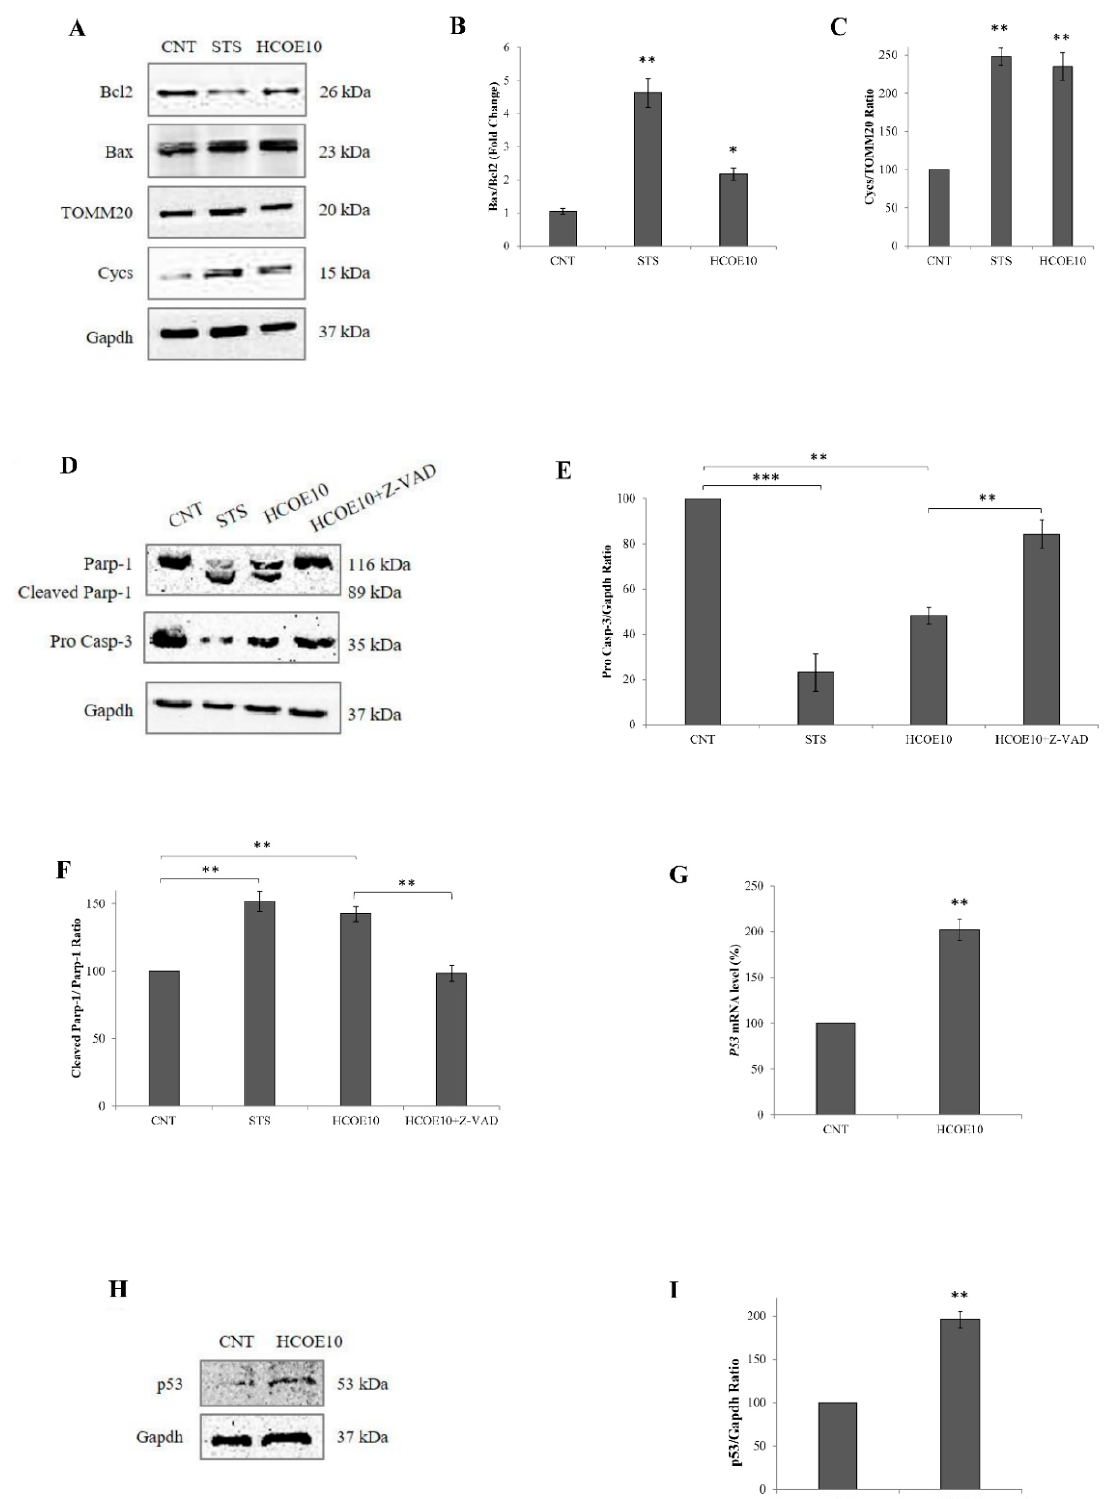
Figure 5. Analysis of mitochondria, apoptosis, and DNA damage markers. ( A ) Representative Western blotting membranes of Bcl-2, Bax, TOMM20, Cycs, and Gapdh protein levels evaluated in A375 cells treated for 4 h with staurosporine (STS, 2 µ M) (used as positive control) or for 48 h with 10 mg / mL HCOE are shown. Quantitation of Bcl-2, Bax, TOMM20, and Cycs proteins was performed and the ratio between Bax/Bcl-2 ( B ) and Cycs/TOMM20 ( C ) are reported as percentage values, with respect to PBS control (CNT; considered as unit, 100%). ( D ) Representative Western blotting